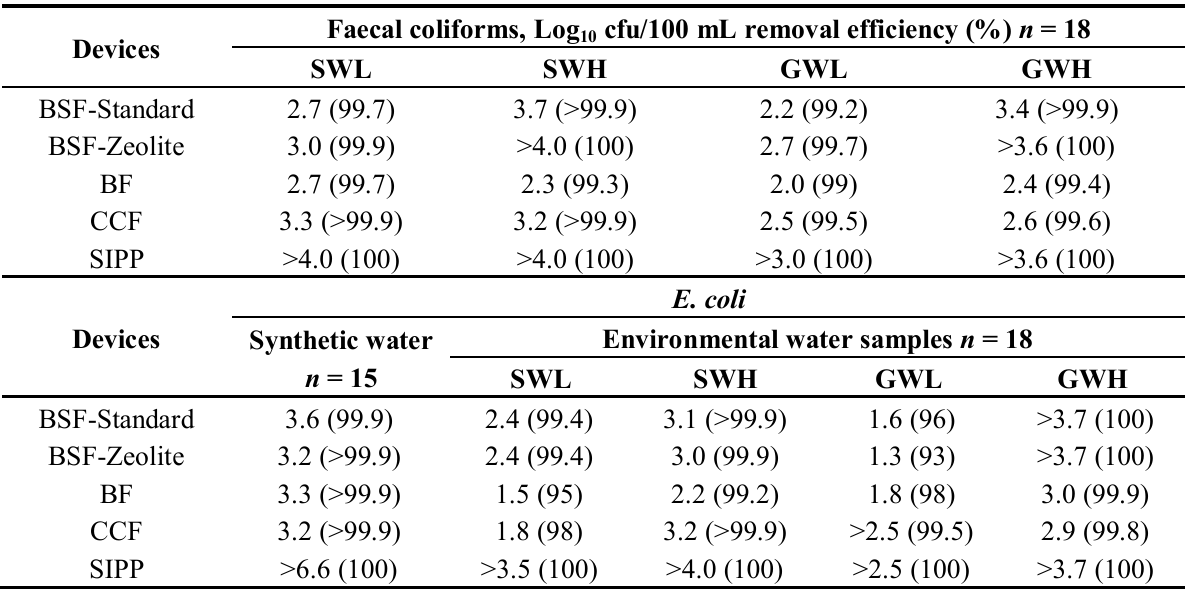
Table 6. Average percentage bacterial removal efficiency of HWTS from test water